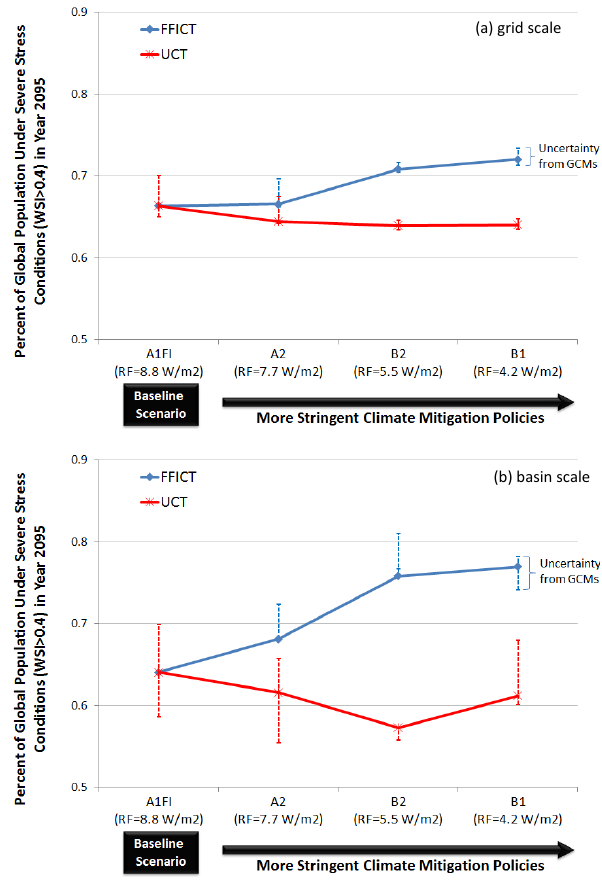
Figure 18. Percent of population living under severe water scarcity Figure 18: percent of population living under severe water scarcity conditions in year 2095 under different climate policies and with increasing stringency; error bars reflect the level of uncertainty if a conditions in year 2095 under different climate policies and with single GCM is used instead of the ensemble of four GCMs increasing stringency; error bars reflect the level of uncertainty if a single GCM is used instead of the ensemble of four GCMs.